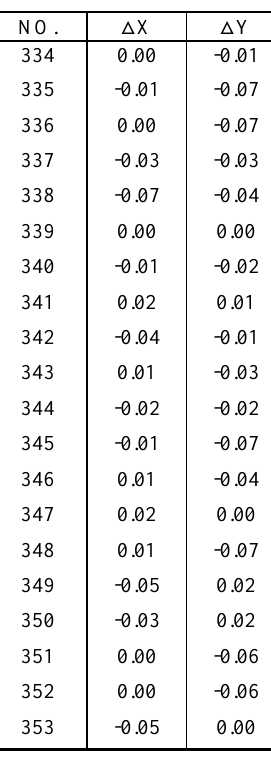
Table 5. Absolute error of ground static calibration model